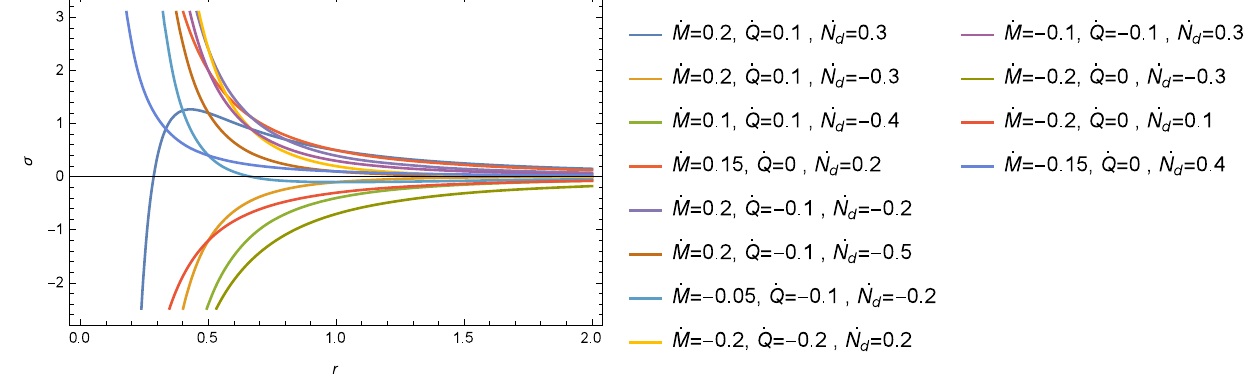
Fig. 3 Radiation-accretion density σ versus the distance r for some typical constant ˙ M , ˙ Q and ˙ N d values for (cid:2) = + 1 in the dust background. Here, we have set Q = 1 for simplicity